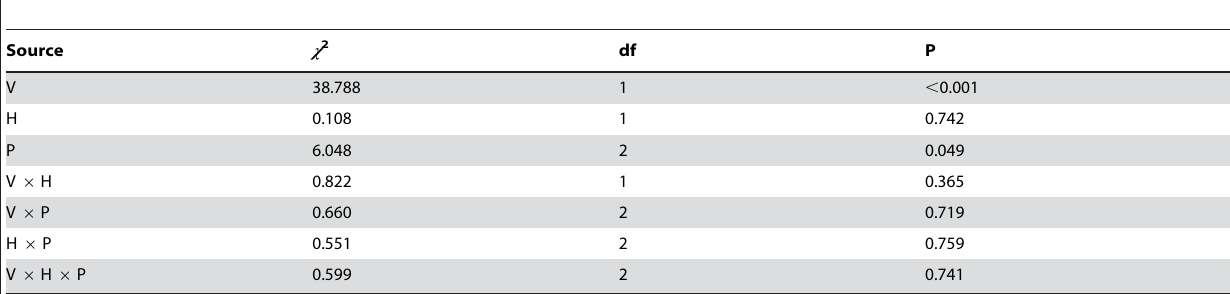
Table 2. Effects of water volume (V), water heterogeneity (H), and soil profile (P) on mean relative soil moisture content.